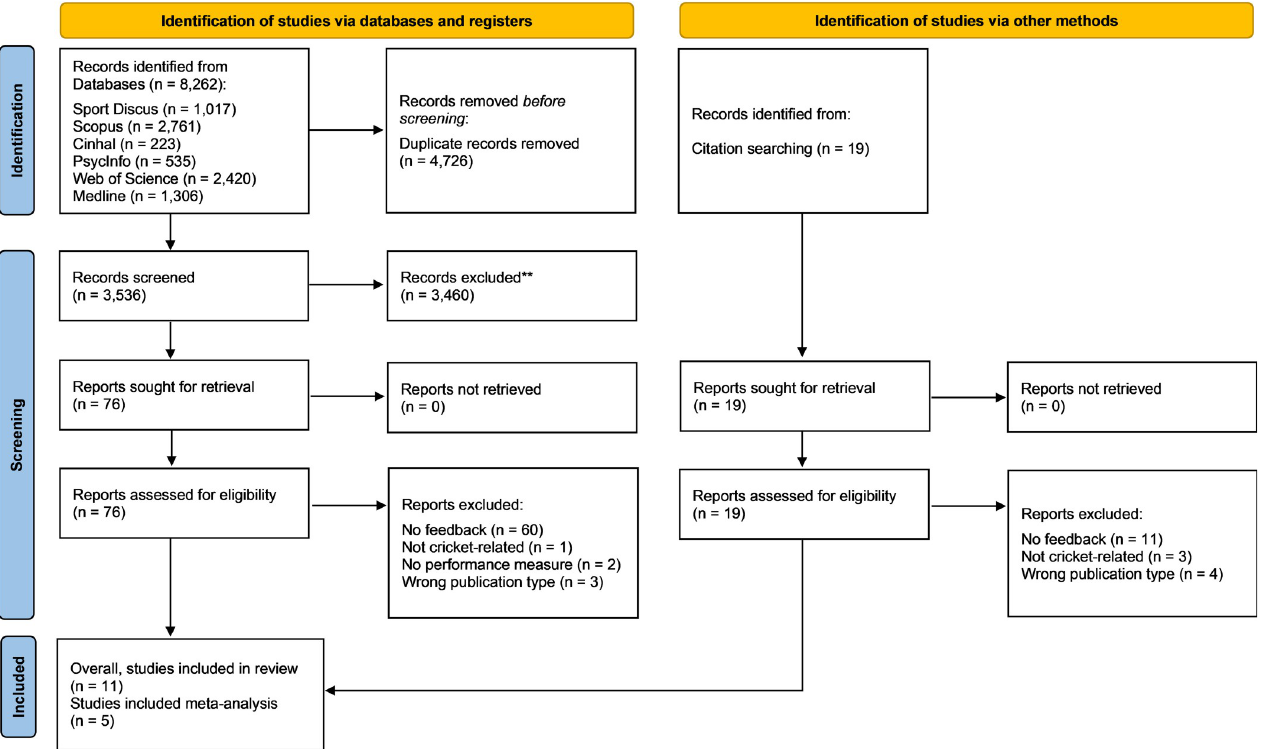
Fig 1. PRISMA flowchart of search strategy, study selection and exclusion reasoning.